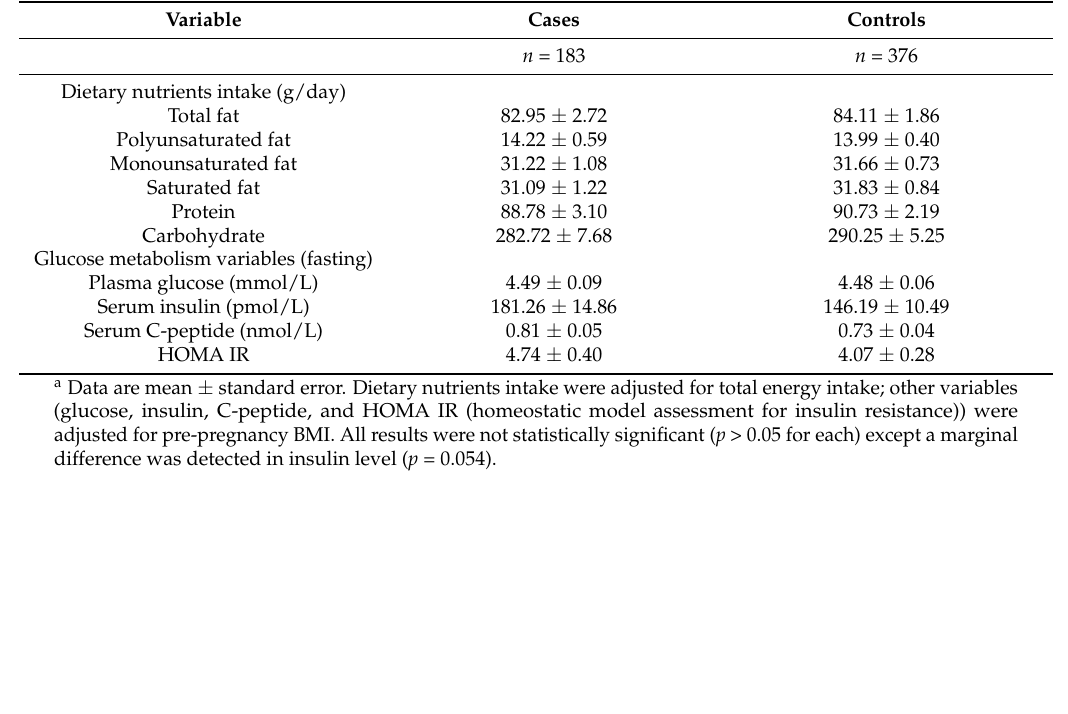
Table 2. Maternal glucose metabolism parameters and dietary macronutrient intake in spontaneous preterm delivery cases and term controls a